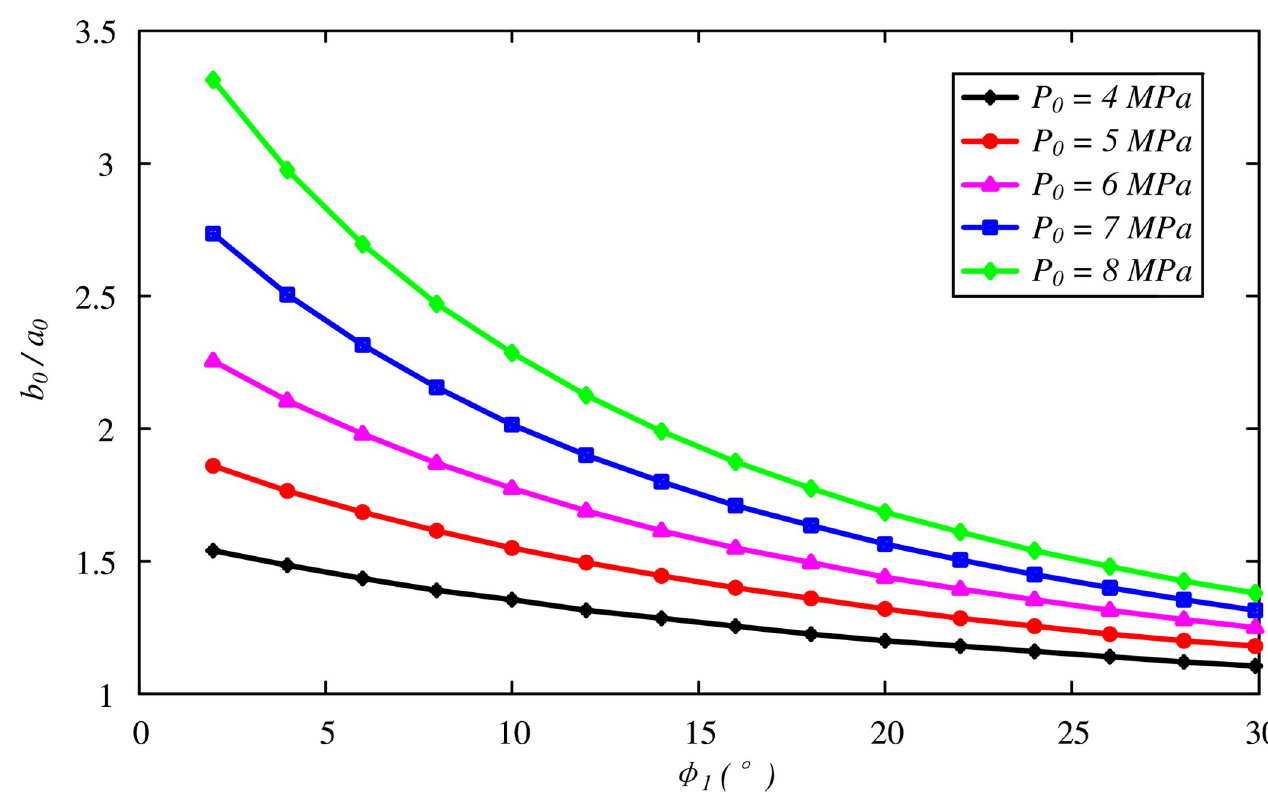
Fig 5. Variation of optimal thickness of the FSW with friction angle ϕ 1